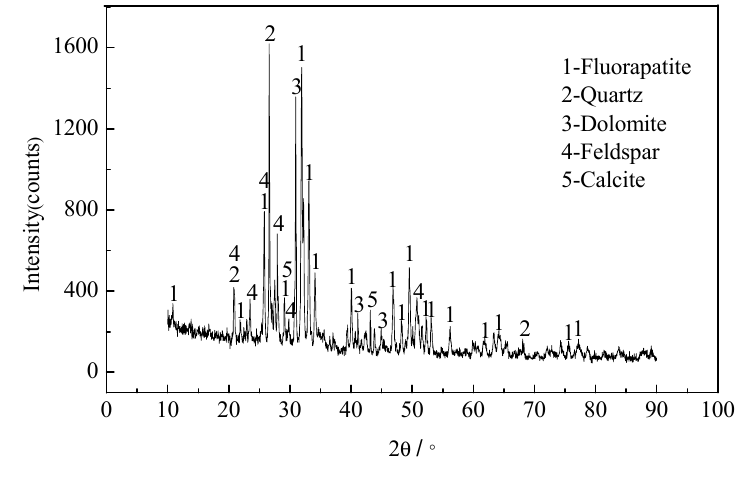
Figure 1. XRD image of raw ore. Table 2. Mineral composition of raw ore.